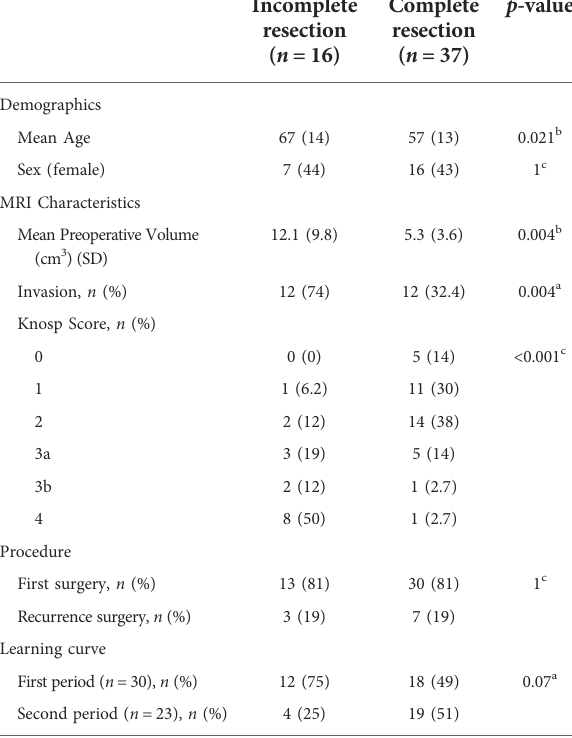
TABLE 3 Factors associated with GTR during initial